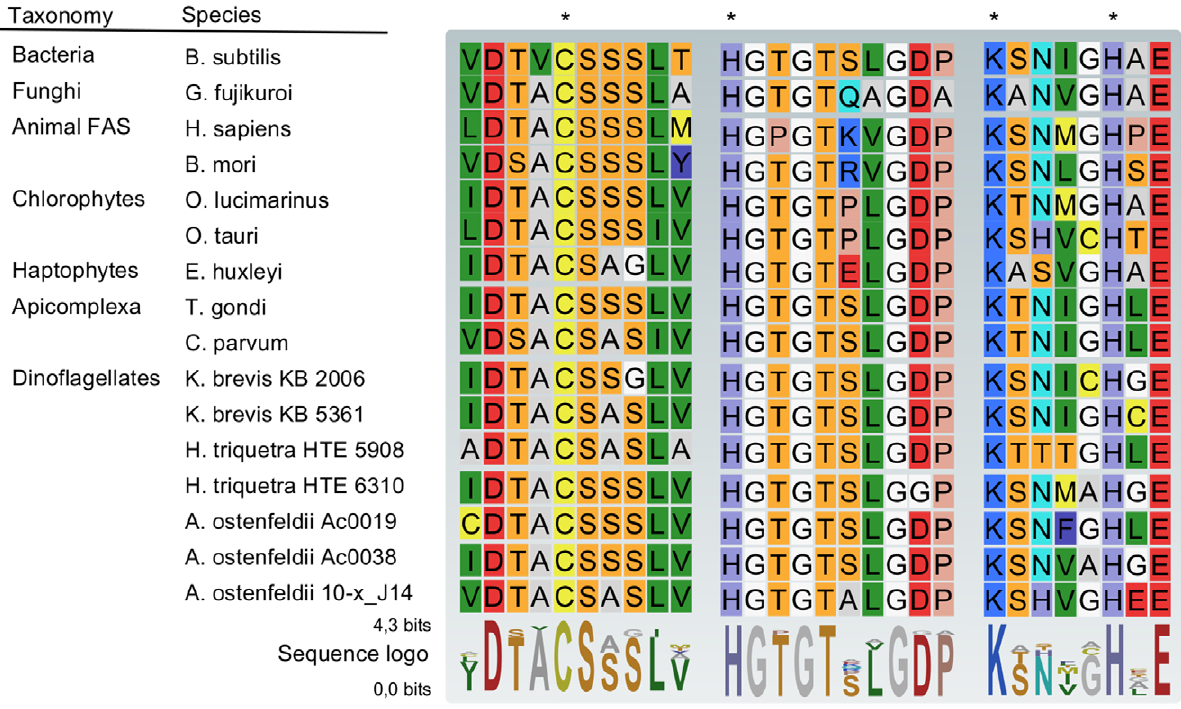
Figure 1. Conserved active site motifs of the ketoacyl synthase domain from different evolutionary distinct supergroups . A special emphasis was thereby given to protistan Type I PKS (Chlorophyta, Haptophyta, Apicomplexa and Dinoflagellata). A sequence logo of the active site motifs is given beneath the alignment; the height of the letters thereby indicates the degree of conservation. The three A. ostenfeldii KS sequences (Aost ac0019, Aost ac0038, and Aost 10-x_J14) and the two H. triquetra KS sequences (Hcaps HTE 5908 and Hcaps HTE 6310) contain all four active site amino acids [20] as is indicated by an asterisk. doi:10.1371/journal.pone.0048624.g001 PLOS ONE |